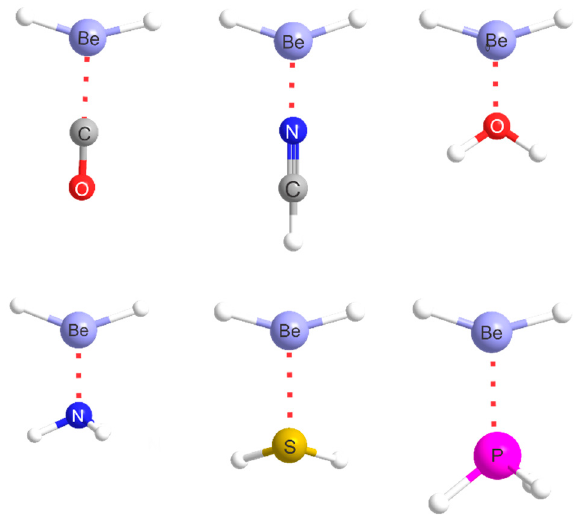
Figure 4. Geometries (drawn to scale) of six B···BeH 2 complexes optimized at the CCSD(T)/aug-cc-pVTZ level of theory, where B = CO, HCN, H 2 O, NH 3 , H 2 S and PH 3 .